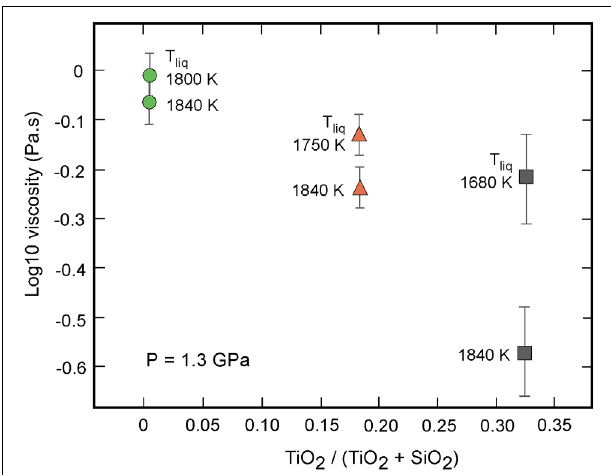
FIGURE 7 | The viscosity of lunar melts as a function of the titanium content TiO 2 /(TiO 2 + SiO 2 ). To asses melt compositional effects, experimental viscosity data of samples G2, O1, and B1A were extrapolated to (i) their respective liquidus temperatures at 1.3 GPa, and to (ii) a common pressure – temperature of 1.3 GPa – 1840 K using the present Arrhenius parameters. At similar P-T conditions, the viscosity is found to significantly decrease with the Ti